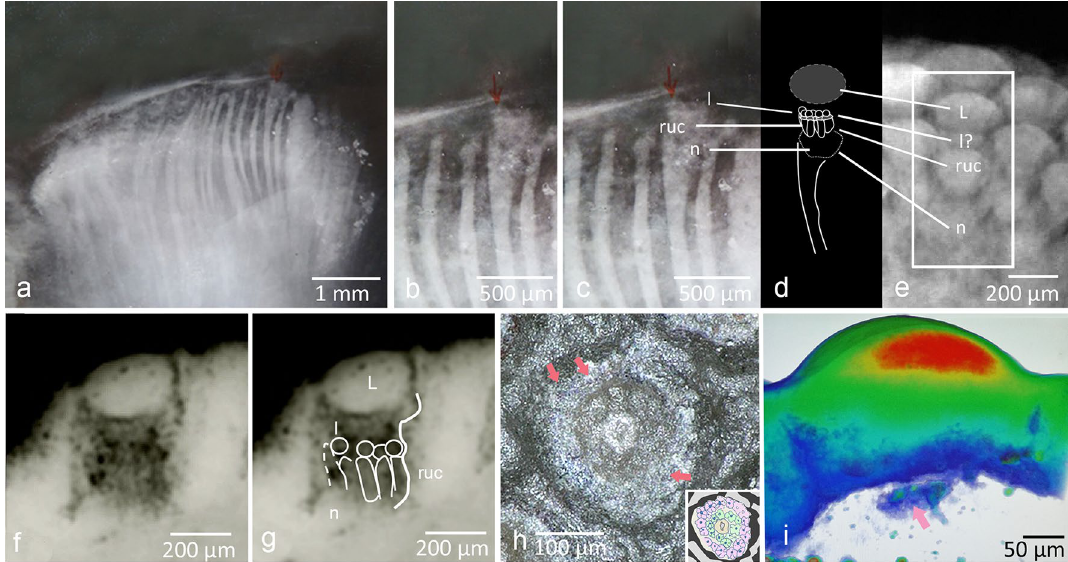
Figure 3. Structure of the hyper-compound eye of phacopid trilobites. ( a ) Chotecops ( Phacops ) ferdinandi (Kayser, 1880), [WS 11352c], X-ray of abraded compound eye with ‘ fibers ’ and Stürmer’s red arrow. ( b ) Section of a. ( c ) Section of a, slightly brightened at the red-arrow-zone. ( d ) Schematic drawing of b. ( e ) µ-ct , Geesops schlotheimi (Bronn, 1825), Phacopida, showing a complete visual unit, comparable to those of C. ferdinandi in c. ( f ) Synchrotron radiation, longitudinal aspect of visual unit of Barrandeops cf. granulops Chatterton et al. 2006. ( g ) Interpretative drawing of f; small ommatidia hiding below a common wide lens. ( h ) Phacops imitator Struve, 1970; two concentric rows of ommatidia, pink arrows: rhabdoms. Insert: interpretative line drawing. pink: outer row of ommatidia, green: inner row of ommatidia, brown: central element, black: probably pigment, grey: cuticle ( i ) G. schlotheimi , synchrotron radiation, equal density colour coded, arrow: crown of sub-ommatidial lenses. L covering lens, l lenses of ommatidal sub-systems, ruc receptor unit’s complex, n